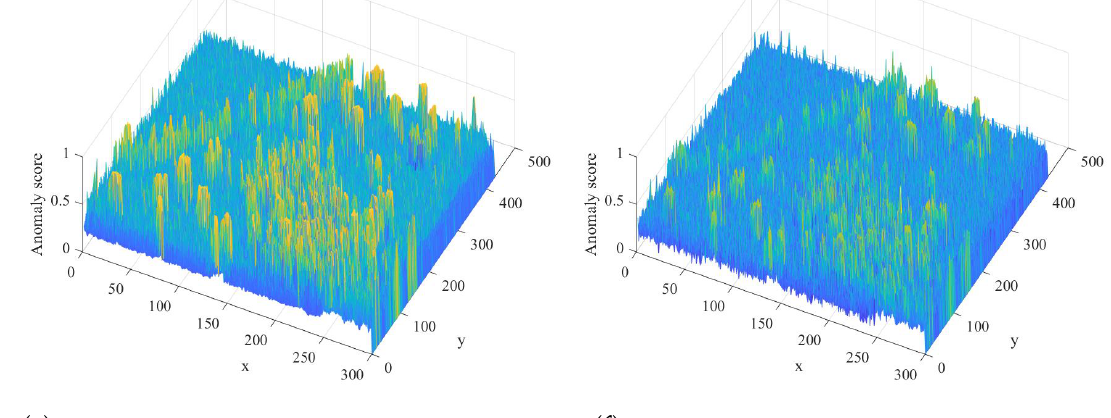
Figure 21. The detection results for Los Angeles data